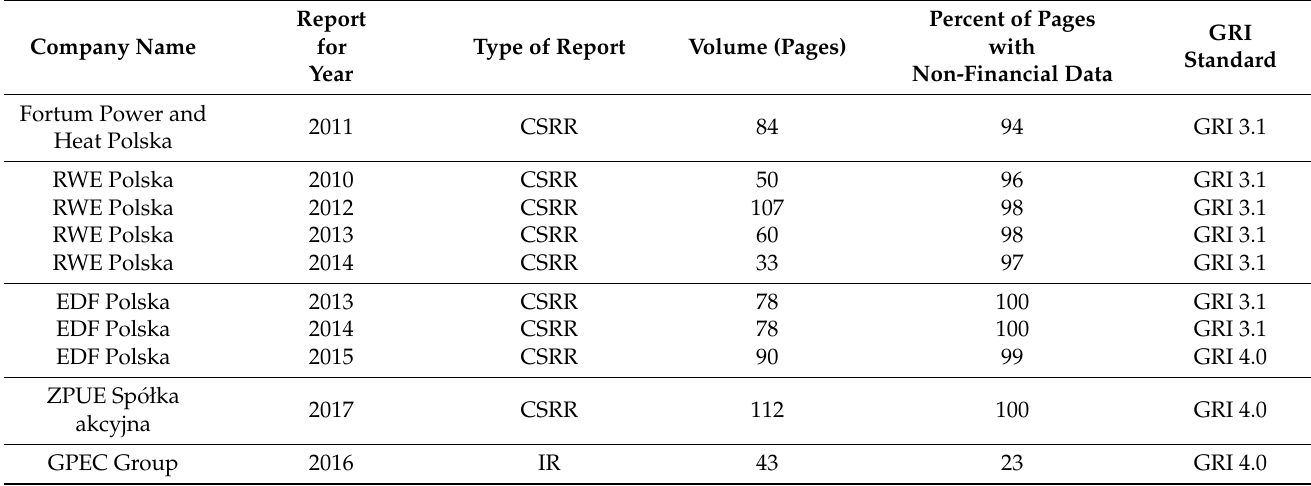
Table 2. Overview of analyzed CSRRs and IRs of companies operating in the energy sector (2011–2021